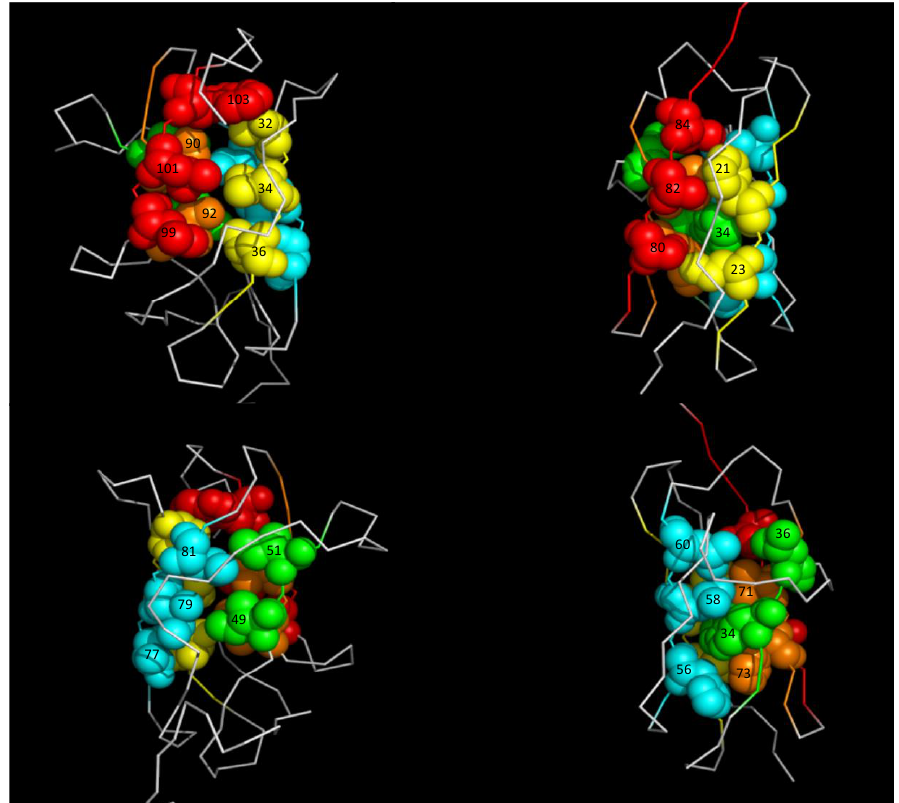
Figure 8. Comparison of the hydrophobic core of DEN4-ED3 and Titin I27. Two views related by a 180 ◦ rotation along the vertical axis of the hydrophobic core of (left) DEN4-ED3 and (right) Titin I27. The color coding is as follows: B (or ß2 for DEN4-ED3, according to Volk et al. [15]) strand, yellow; C (ß4) strand, green; E (ß7) strand, blue; F (ß8) strand, orange; G (ß9) strand, red. The labels stand for the residue numbers, as reported in the PDB (1TIU for Titin I27, 2H0P for